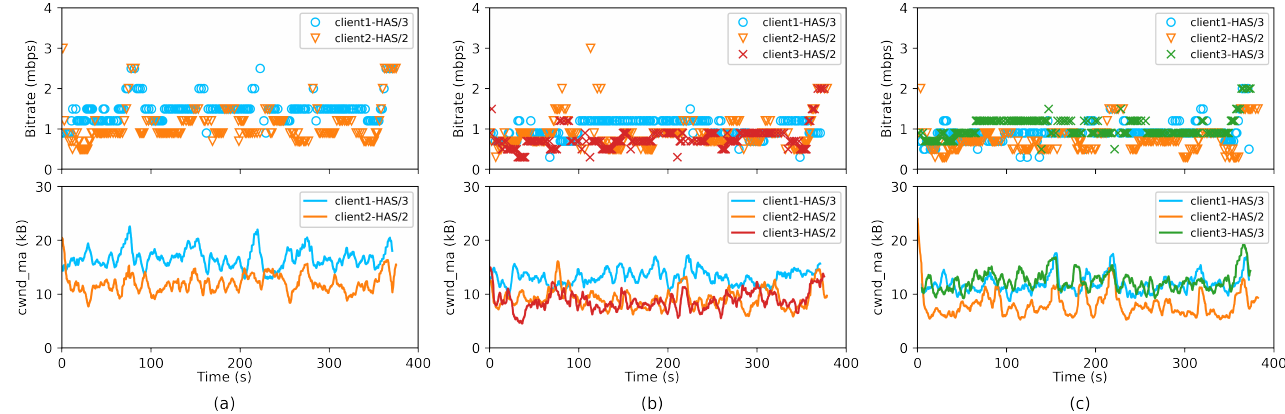
Figure 3. The representative time-varying bitrates and cwnd _ ma of the clients running the general ABR with B = 3 (mbps), under the scenario ( a ) S 11 , ( b ) S 12 and ( c ) S 21